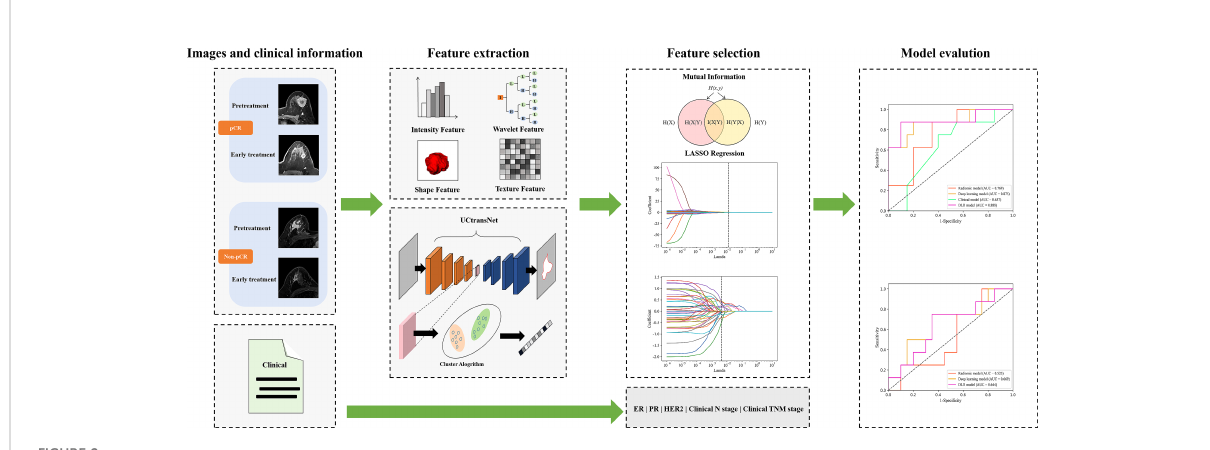
FIGURE 2 The work fl ow for building DLR